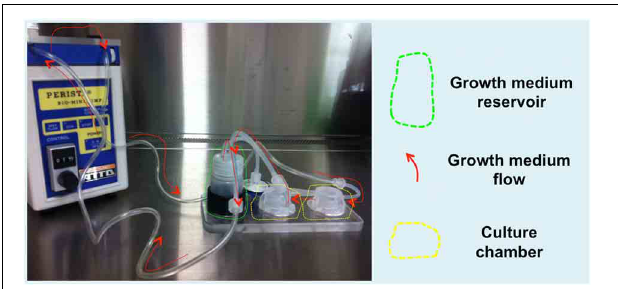
FIGURE 1 | QuasiVivo Bioreactor (QV500). The bioreactor is composed of a peristaltic pump keeping a constant medium flow rate (200 μ l/min) from the growth medium reservoir to two culture chambers connected in series, thus allowing scaffold inner layer